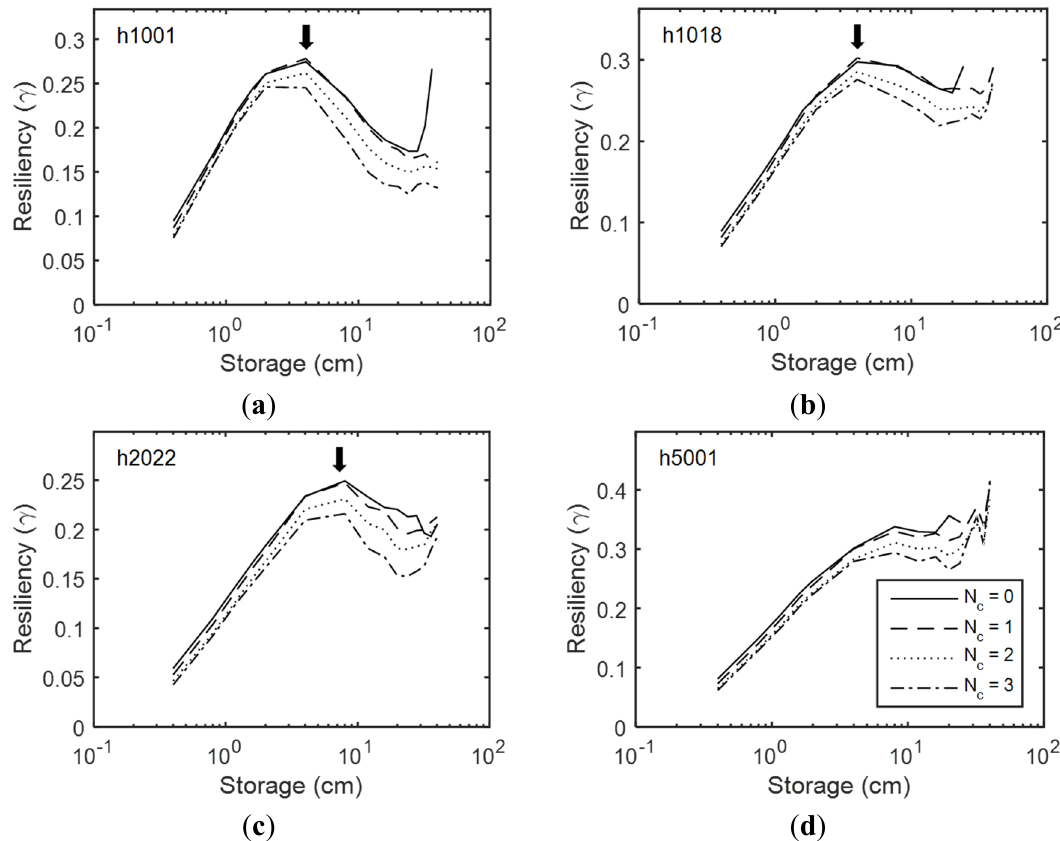
Figure 5. Resiliencies of the four RBSNs under the historical rainfall (1970–1999) for the test catchments ( a ) 1001; ( b ) 1018; ( c ) 2022 and ( d )